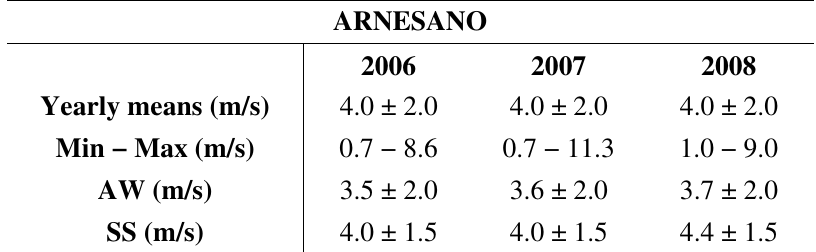
Table 5. Yearly means, minimum (Min), maximum (Max), autumn-winter (AW), and spring-summer (SS) mean values ± 1 SD deviation of wind speed mean values (WSav (m/s)) at Arnesano in 2006, 2007, and